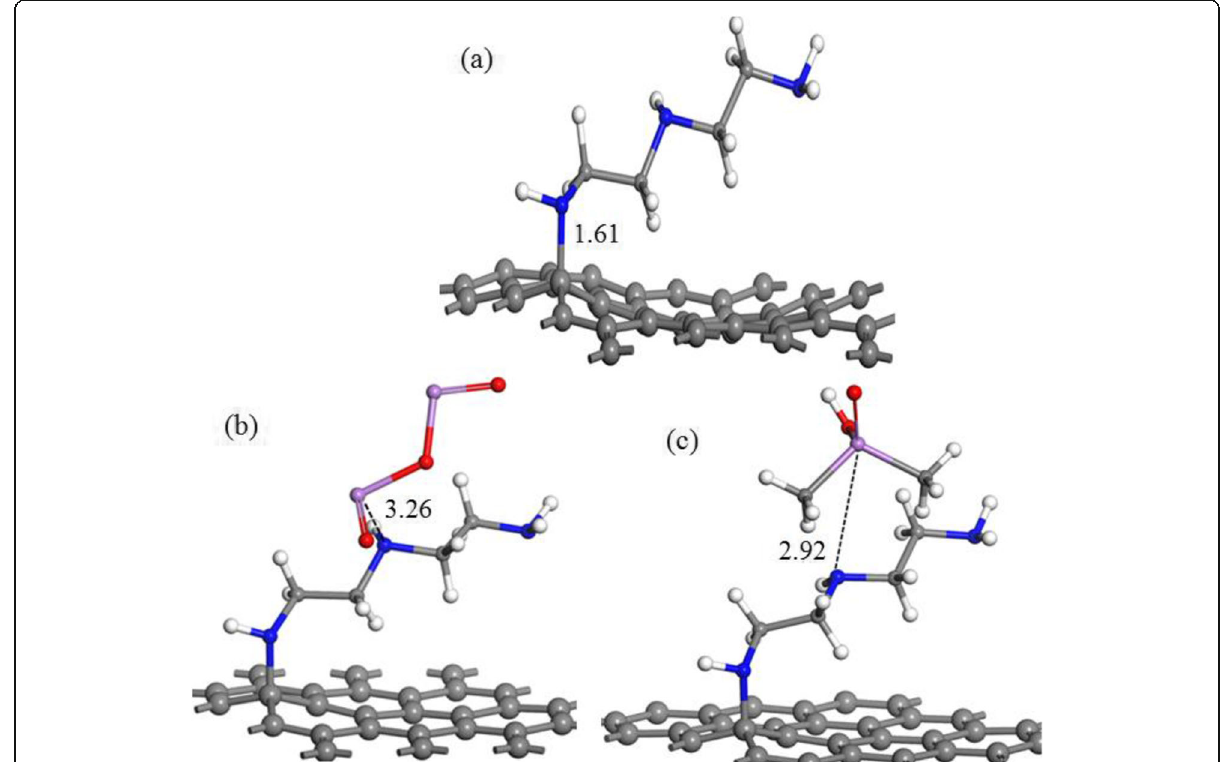
Fig. 9 Configurations of ( a ) As (III) and ( b ) DMA adsorption on DETA-SBC